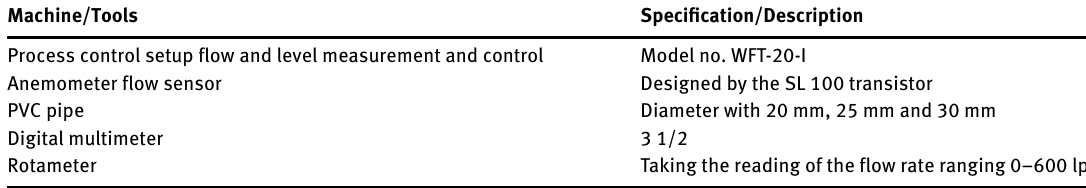
Table 1: Experimental